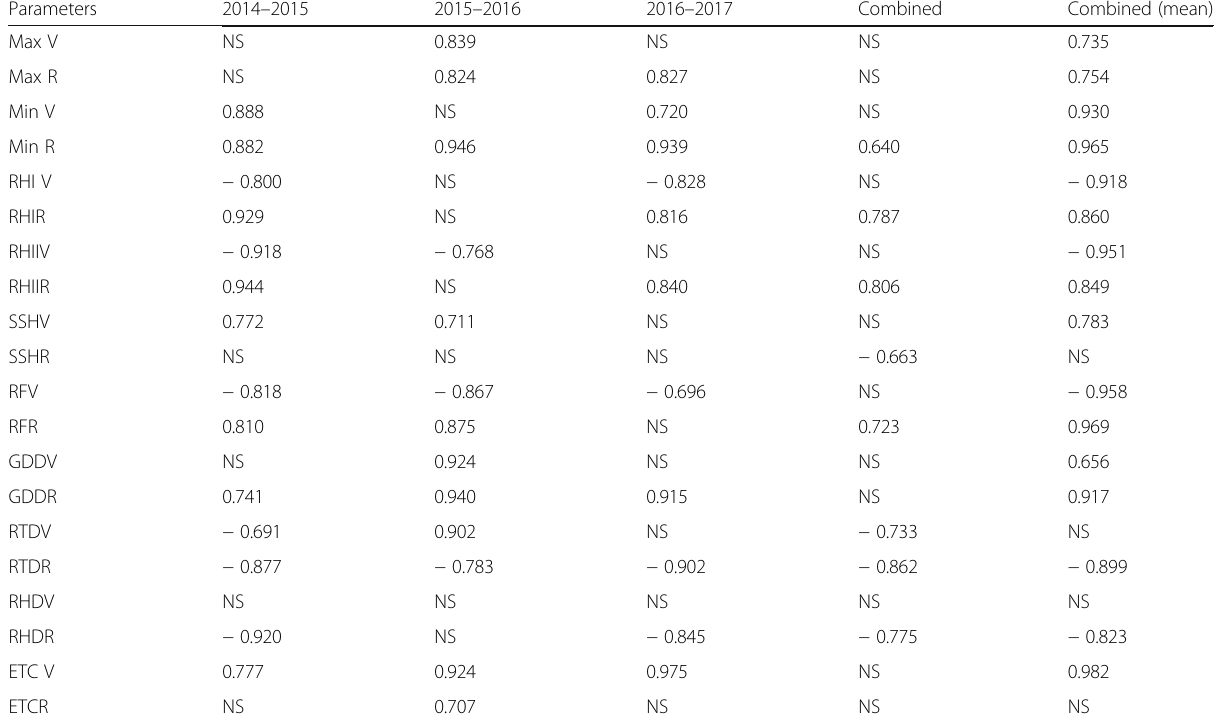
Table 9 Seed cotton yield (q/ha) correlation with weather parameters Parameters